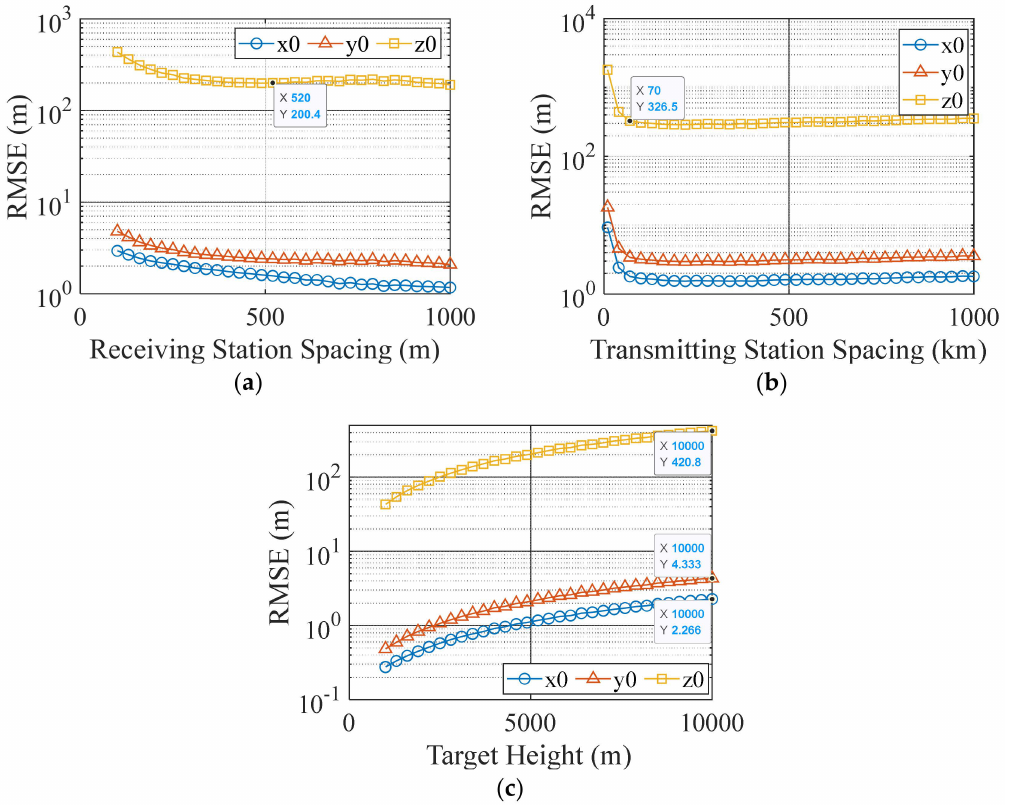
Figure 4. Influence of system structure on the accuracy of the initial position. ( a ) Influence of receiver spacing. ( b ) Influence of transmitter spacing. ( c ) Influence of target